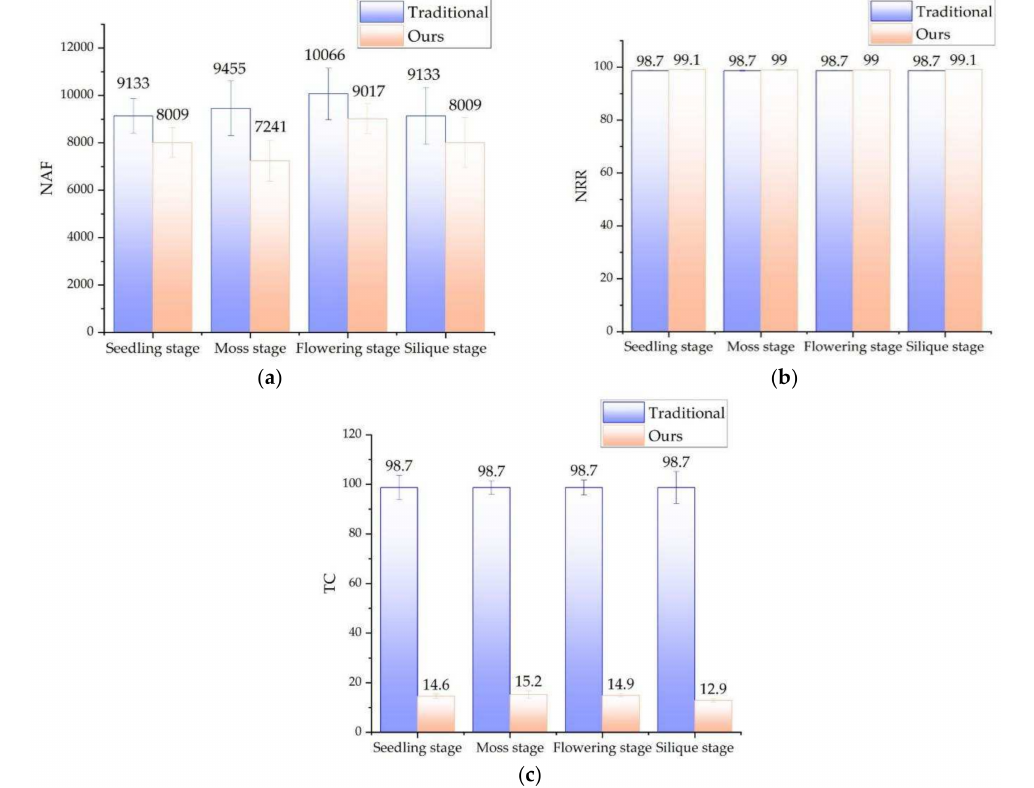
Figure 9. Comparison of the effect of the traditional method and ours. ( a ) comparison of the NAF. ( b ) comparison of the NRR. ( c ) comparison of the time consuming. Note: NAF: Means number of point clouds after filtering. NRR means noise reduction ratio, NRR = (1 − number of point clouds after denoising/number of original point clouds) ∗ 100. TC: Time consuming (Second).